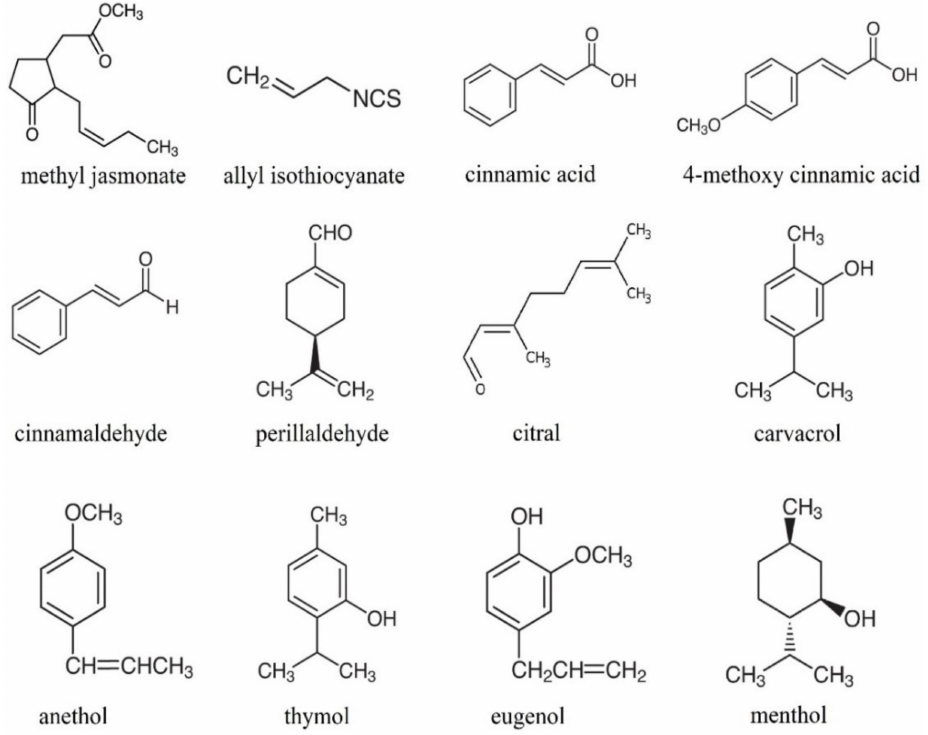
Figure 1. Chemical formulae of some essential oils’